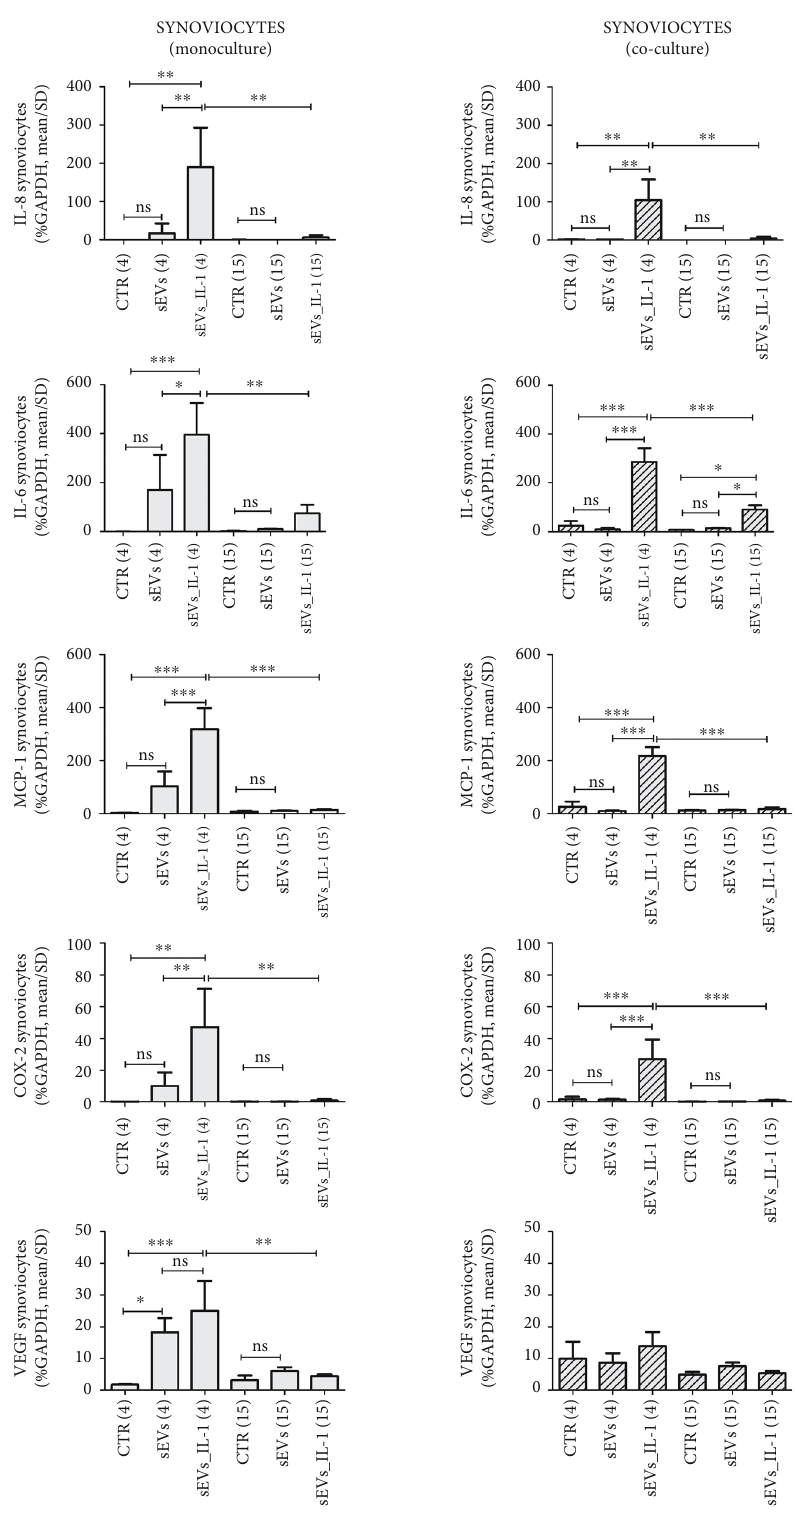
Figure 4: sEVs_IL-1 e ff ects on gene expression of major in fl ammatory genes in synoviocytes kept in control conditions. The fi gure reports the e ff ects on gene expression of major in fl ammatory molecules (IL-8, IL-6, and MCP-1) and molecules involved in angiogenesis (VEGF) and pain (COX-2) in synoviocytes grown in both monoculture (grey pattern, left graphs) and co-cultured with chondrocytes (grey dashed pattern, right graphs) in CTR, sEVs, or sEVs_IL-1 conditions. Data were normalized to GAPDH. Each graph reports data collected from 3 independent sEVs samples and expressed as means ± SD . The means of the groups were compared by ANOVA, followed by Tukey ’ s post hoc test, with ∗ p < 0 : 05 , ∗∗ p < 0 : 01 , and ∗∗∗ p < 0 : 001